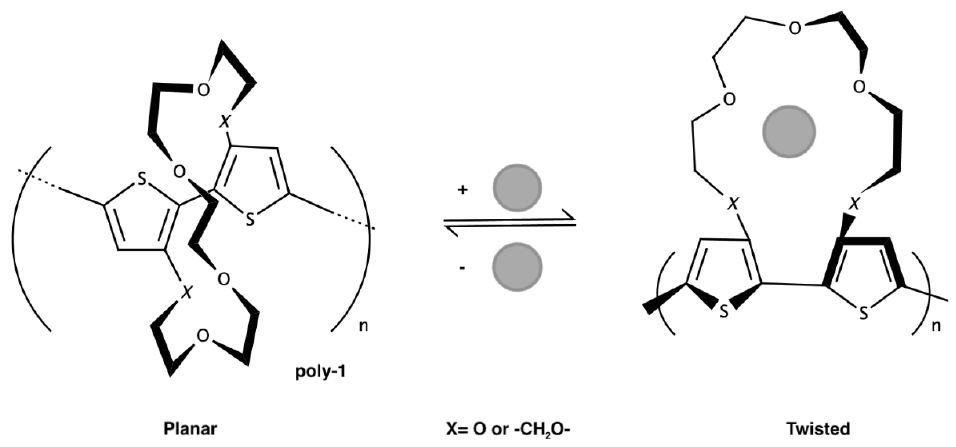
Figure 21. Crown ether modified polythiophene for sensing of alkaline metal cations. (Adapted with permission from [69], Copyright 1995, ACS)